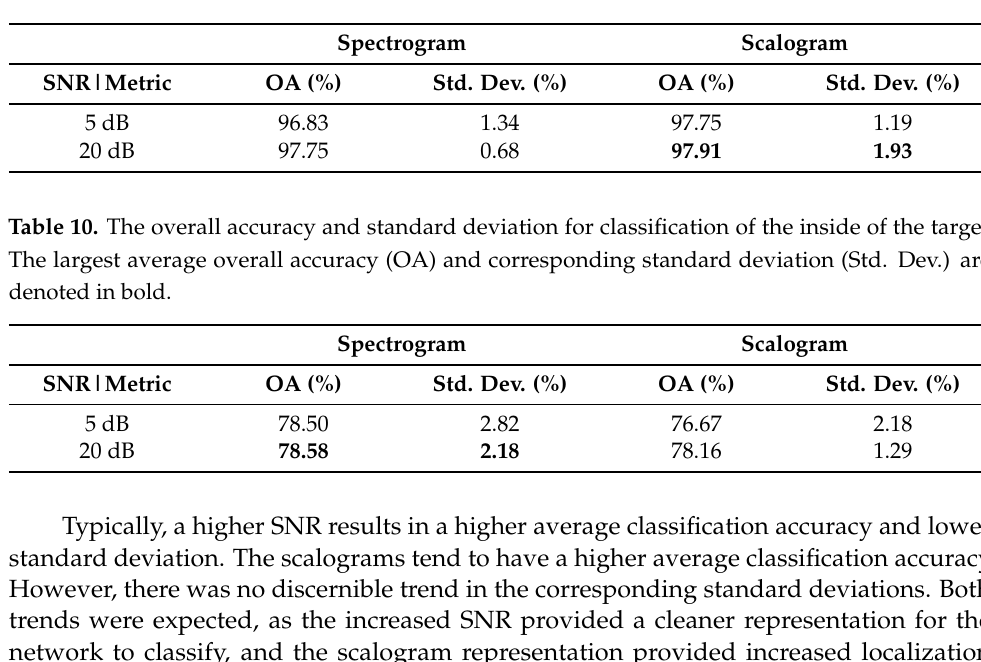
Table 9. The overall accuracy and standard deviation for classification of geometry of the target (solid or shell). The largest average overall accuracy (OA) and corresponding standard deviation (Std. Dev.) are denoted in bold.